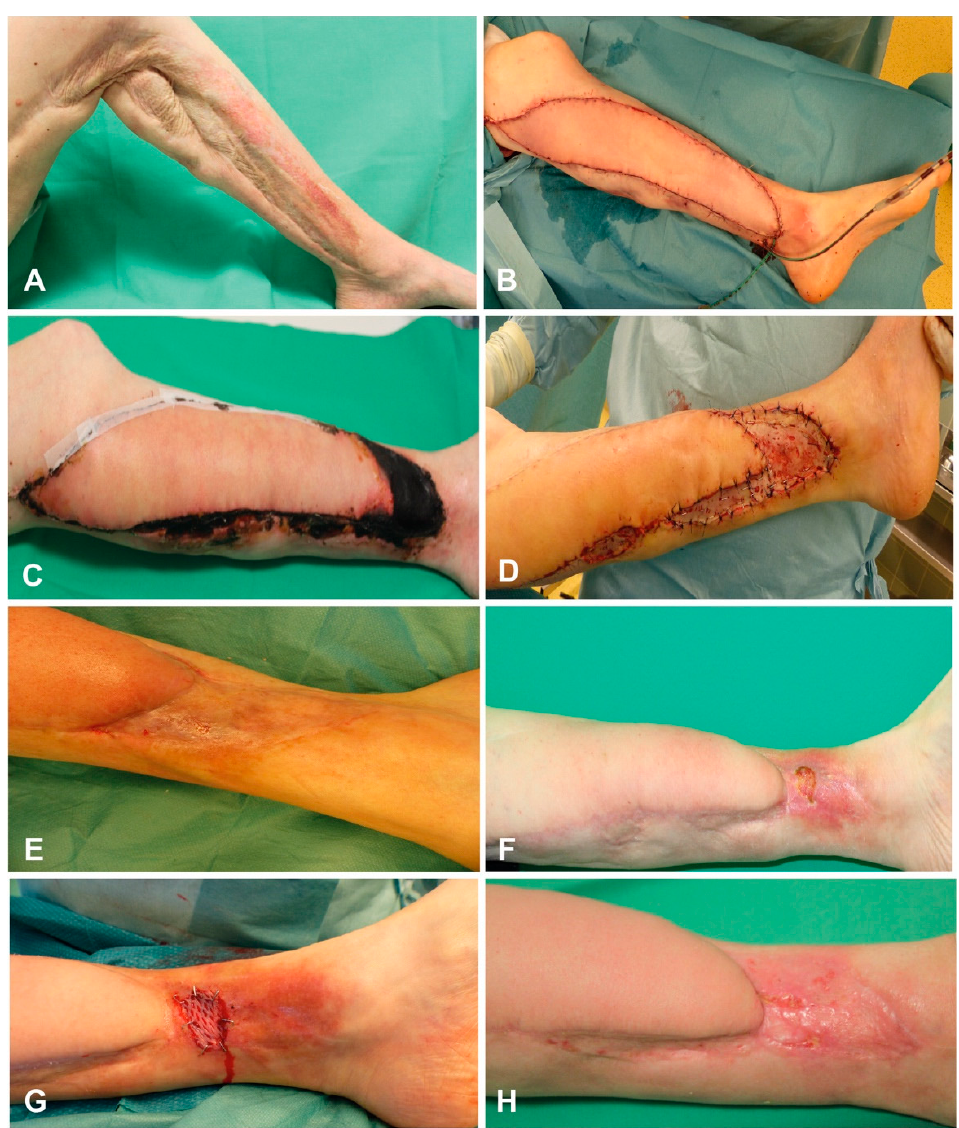
Figure 8. ( A ) Fragile and painful scar of the left leg, ( B ) Intraoperative picture after excision of the scar and reconstruction of the lower leg using latissimus dorsi muscle free flap, ( C ) Development of margin necrosis, ( D ) Excision of the flap margin necrosis and skin graft transplantation, ( E ) complete healing of the wound, ( F ) Development of a small wound, ( G ) Treatment of the wound using skin graft, ( H ) Final outcome.